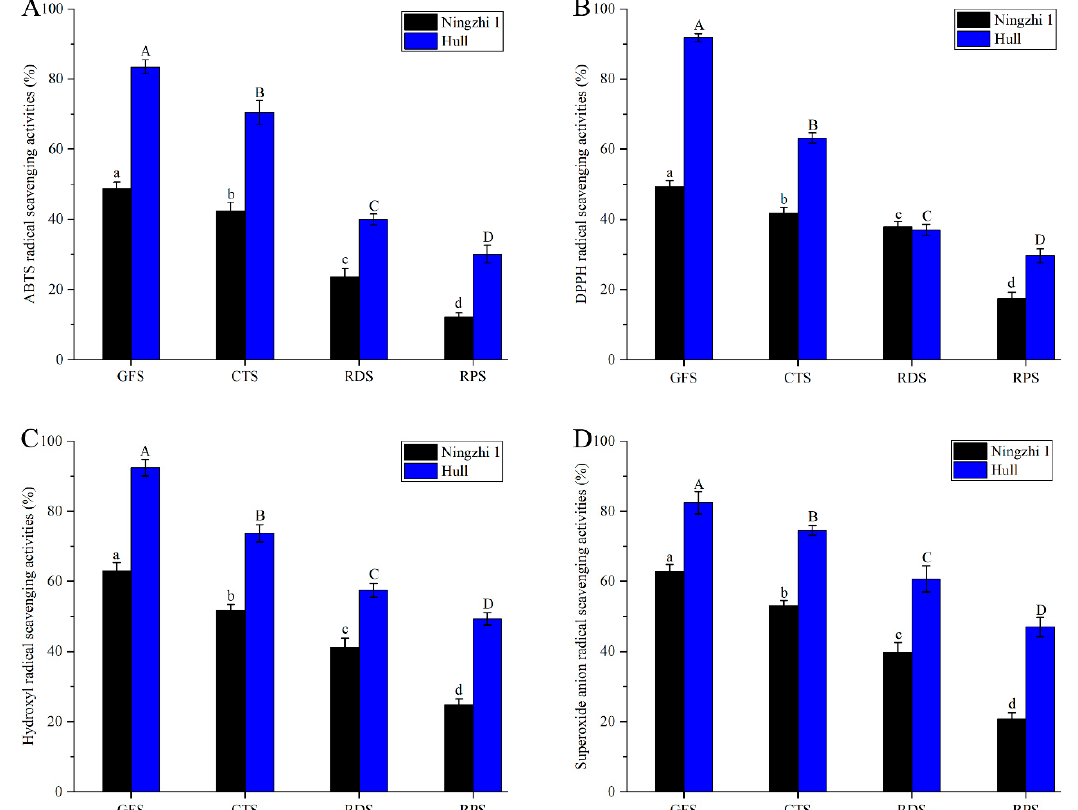
Figure 2. Antioxidant activity of non-anthocyanidin flavonoids in blackberry fruit at different growth stages. ( A ) ABTS radical-scavenging activities. ( B ) DPPH radical-scavenging activities. ( C ) Hydroxyl radical-scavenging activities. ( D ) Superoxide anion scavenging activities. Lowercase letters and uppercase letters mean the significance ( p < 0.05) of antioxidant activity of non-anthocyanidin flavonoids in Ningzhi 1 and Hull blackberry at different growth stages.